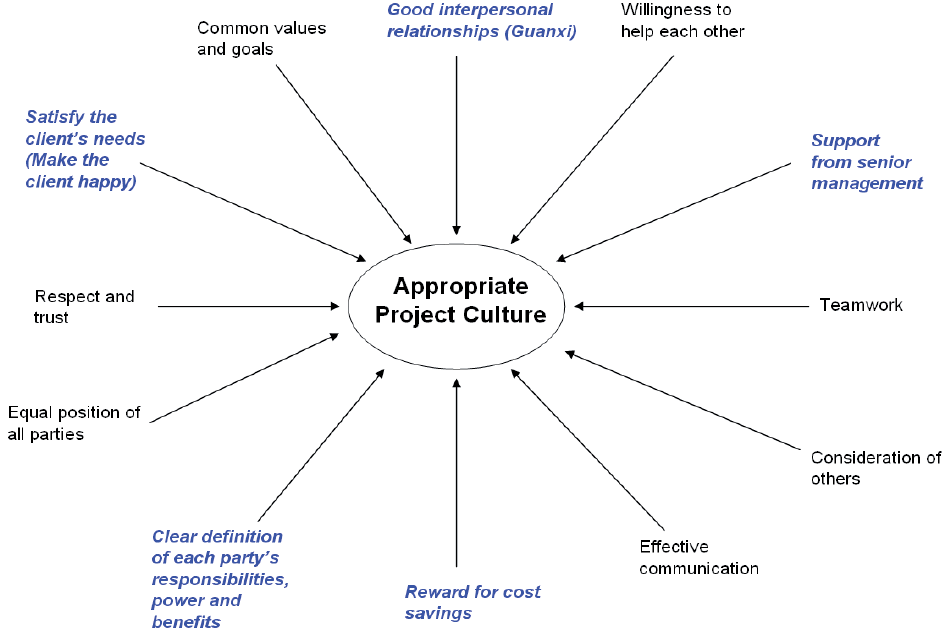
Figure 5: Common features of appropriate project culture, drawn from the interview fi